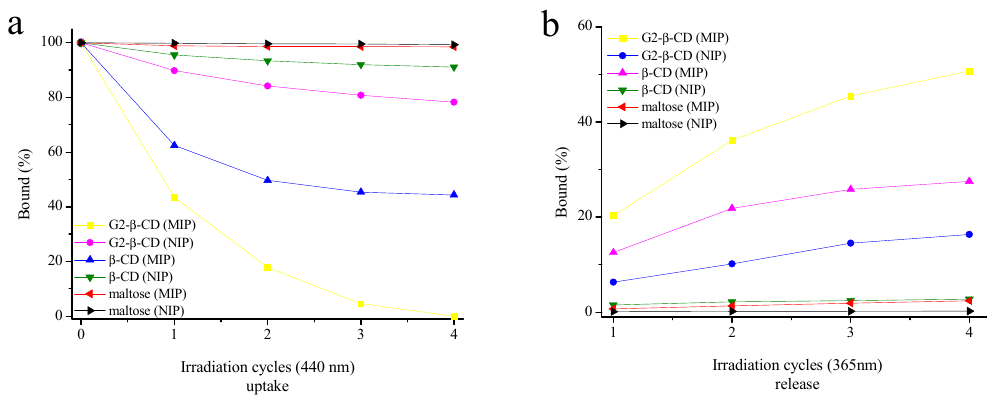
Figure 5. Photoregulated uptake and release of G2- β -CD, β -CD, and maltose by MIP and NIP. ( a ) photoregulated uptake of G2- β -CD, β -CD, and maltose by the MIPand NIP; ( b ) photoregulated releaseof G2- β -CD, β -CD, and maltose by the azocontaining MIP and NIP.